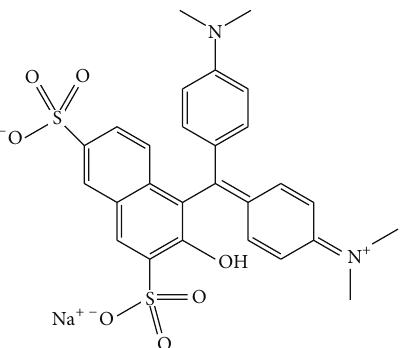
Scheme 1: Molecular structure of the acid green 50